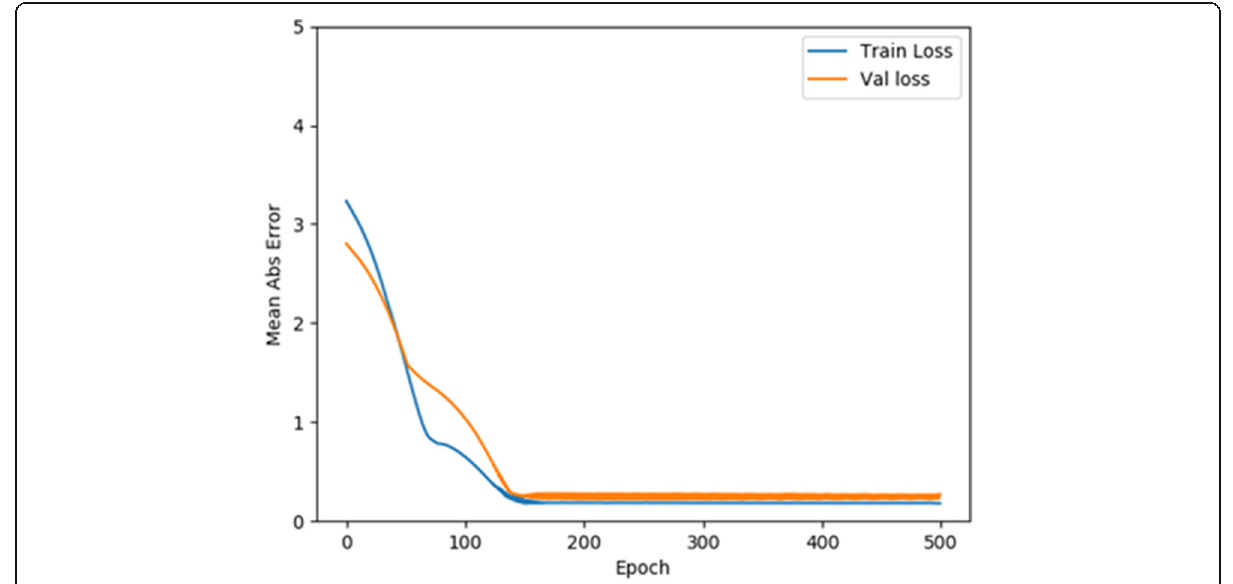
Fig. 8 Changes of mean square error in relate to epoch numbers when best ANN with 150 epoch is trained